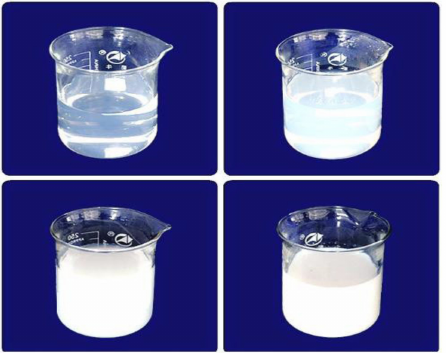
Figure 1. Color according to the size of colloidal silica